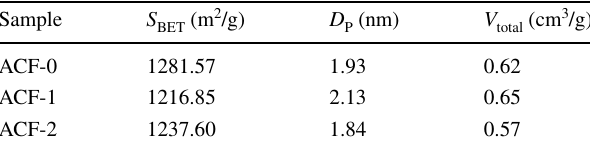
Table 1 Selected properties of ACF-0, ACF-1 and ACF-2 series of samples Sample